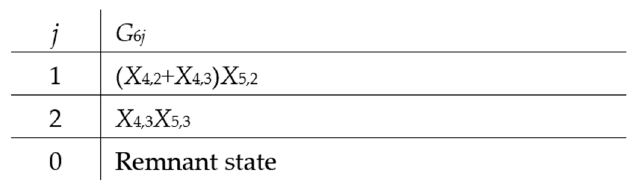
Figure 2. Logic gate specification (LGS6).